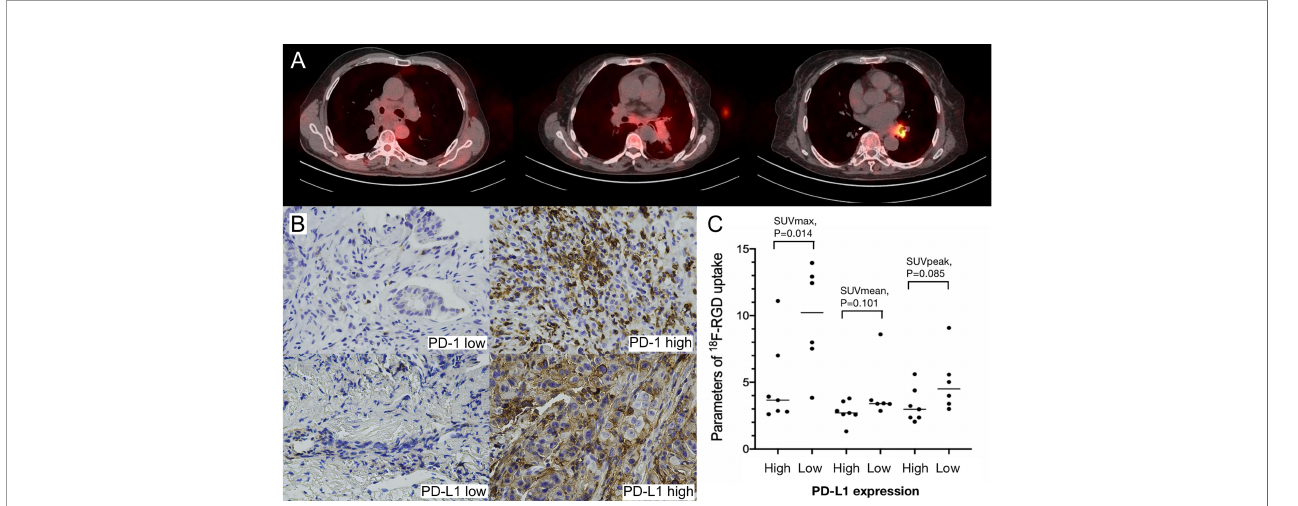
FIGURE 3 | (A) Low, middle and high uptakes of 18 F-RGD PET/CT scanning for NSCLC patients; (B) Relatively low and high expression of PD-1 and PD-L1 (×400) in NSCLC patients; (C) Scatter diagrams of correlations between SUVmax, SUVmean, SUVpeak and PD-L1 expression in NSCLC patients. P < 0.05 is considered statistically signi fi